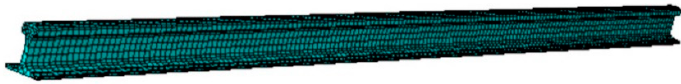
Figure 6. The finite element model of rail.